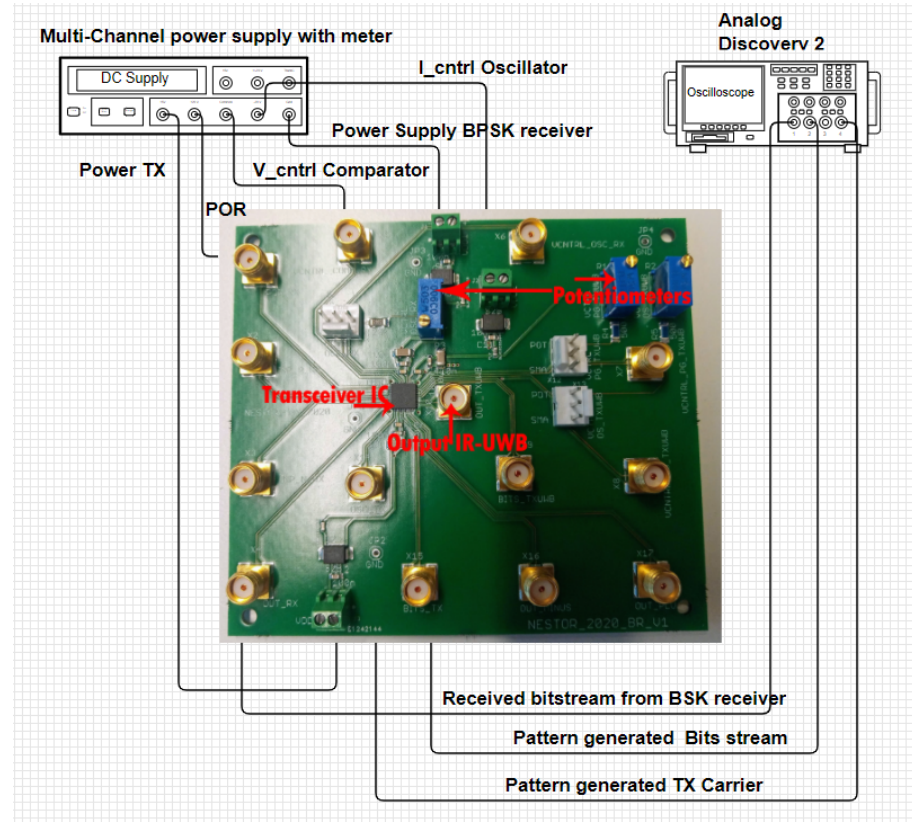
Figure 11. Block diagram of experimental test setup for the BPSK